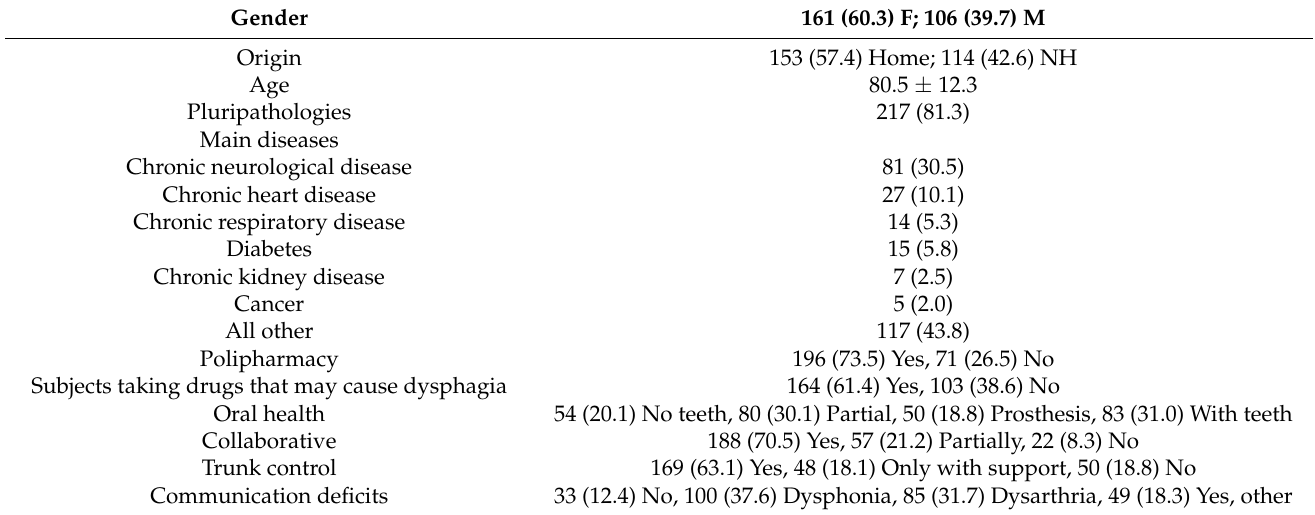
Table 1. Characteristics of out-hospital patients assessed for swallowing difficulties and nutritional status, and main risk factors for dysphagia–mean ± (SD); absolute and relative frequencies